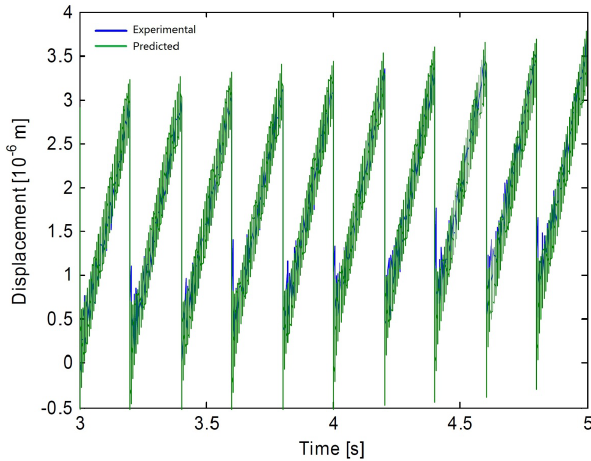
Figure 17. Experimental displacement and displacement predicted using Dahl model.